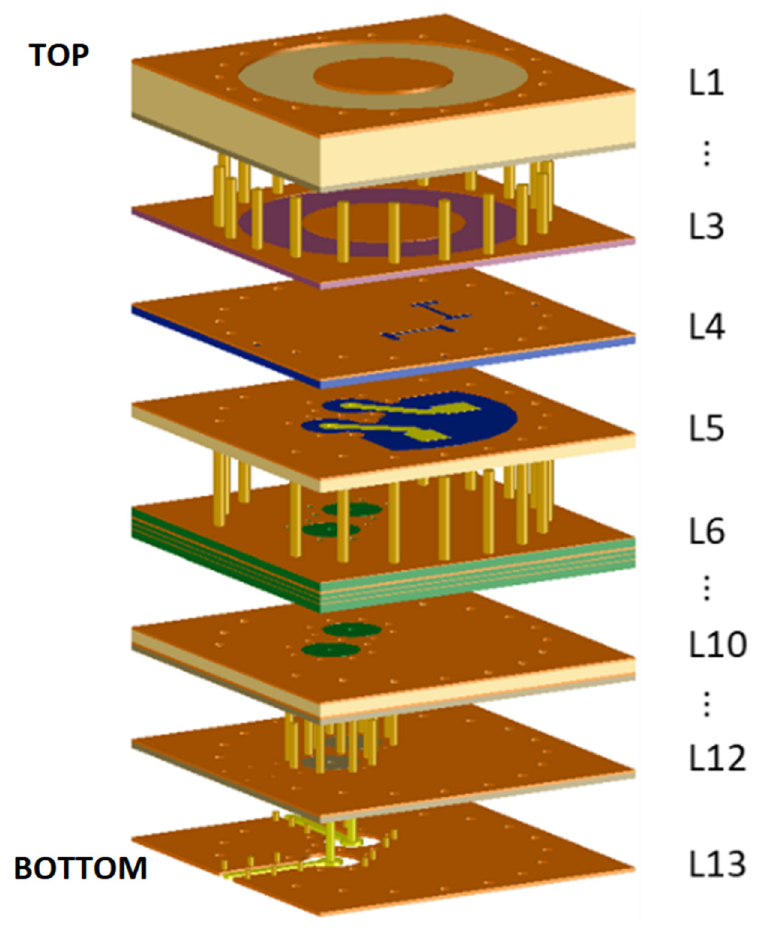
Figure 4. Three-dimensional diagram of the radiating element structure.